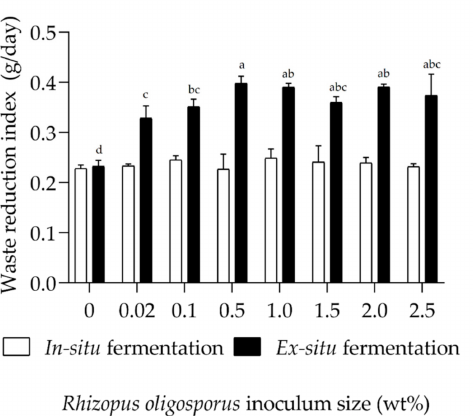
Figure 2. Waste reduction index of CEW by BSFL at various inoculum concentrations of R. oligosporus performing in situ and ex situ fermentations. Mean values with different superscript characters signify the significant differences ( p <